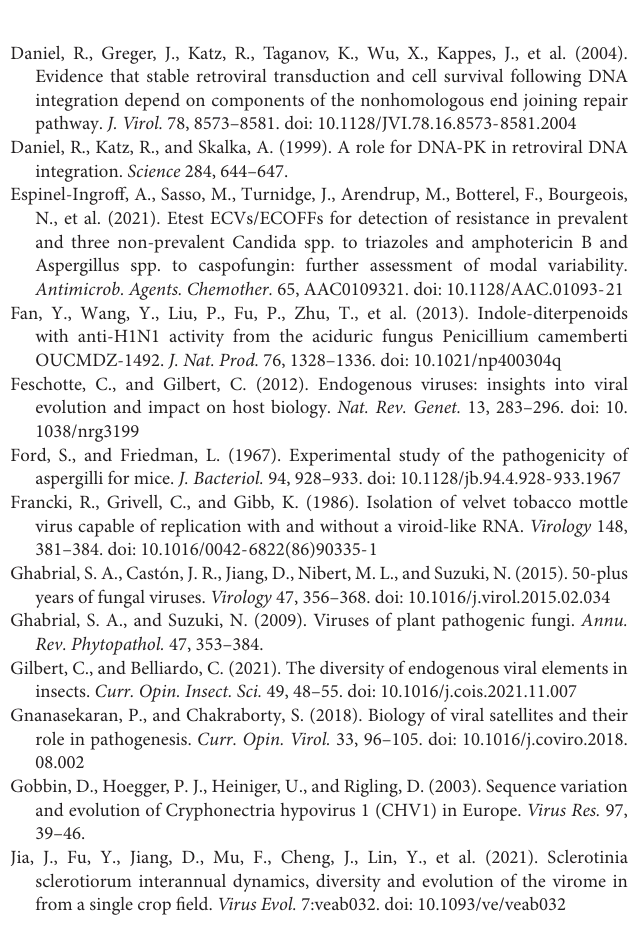
Supplementary Figure S1 | Identity at the 3 (cid:48) -terminal of dsRNA1, dsRNA2, dsRNA3, and dsRNA4. Gray shading indicates where nucleotides are identical in the three segments. Supplementary Figure S2 | dsRNA1, dsRNA2, dsRNA3, and dsRNA4 bands were assessed by treatments with DNase?, RNase A, or S1 nuclease. Supplementary Figure S3 | Agarose gel electrophoresed analysis of dsRNA profiles from mycelia and viral particles. Supplementary Figure S4 | Histological observation at 72 h post-inoculation in lung, liver, and kidney tissue infected with the virus-free isolate (LD-F1), AfPV1-infected isolate (LD-F1-b), and AfPV1- and SatRNA-infected isolate (LD-F1-a); HE staining (A) and GMS staining (B) . Control experiments are comprised of non-treated mice (UTC) and saline buffer injected immunosuppressive mice (Mock). Supplementary Figure S5 | The genes in these pathways (Non-homologous end-joining, Homologous recombination, DNA replication, Mismatch repair, Base excision repair, Nucleotide excision repair, and Indole diterpene alkaloid biosynthesis of A. flavus ) were randomly selected and expression confirmed by